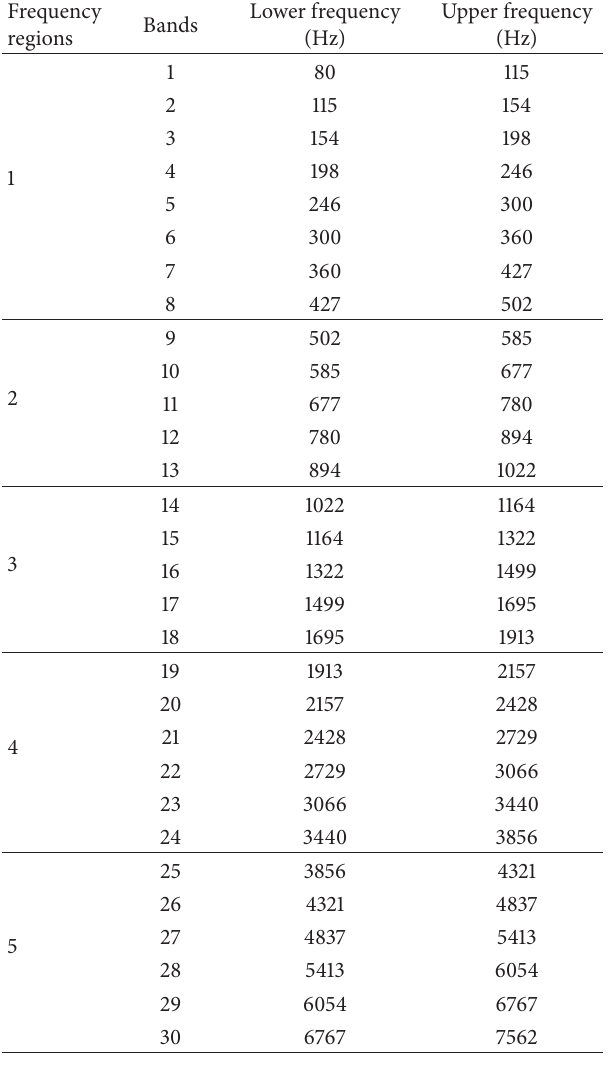
Table 1: Cutoff frequency for extracting temporal envelope infor- mation.